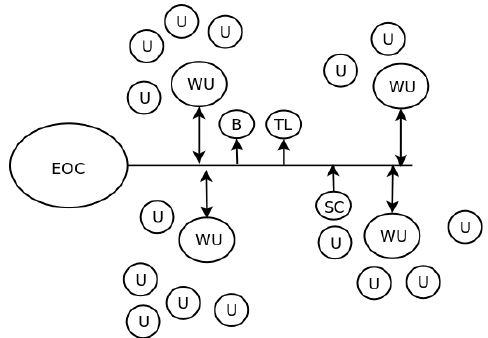
Figure 1. System model: (EOC) Emergency Operation Center, (WU) Witness Unit, (SC) Surveillance Camera, (TL) Traffic Light, (B) Barriers, and (U)